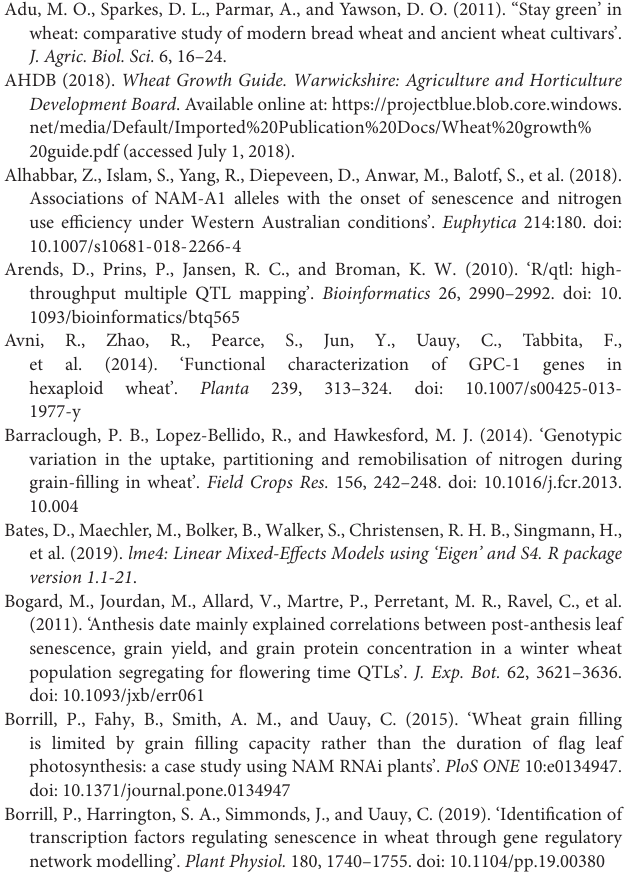
Supplementary Figure 1 | Mean daily rainfall and temperature data for field seasons